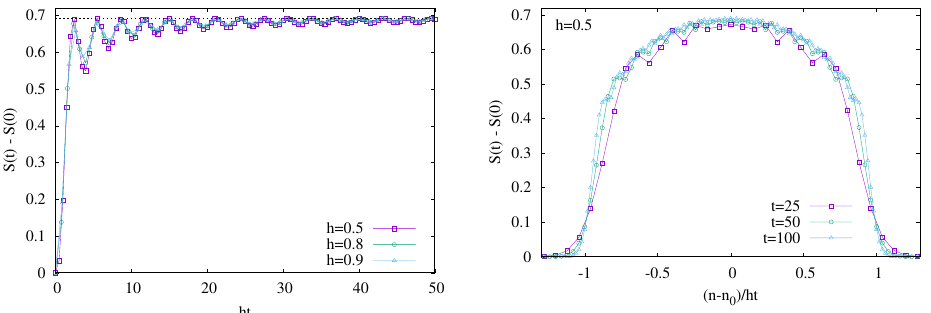
Figure 5: Time evolution of the entanglement entropy for a JW excitation in a chain of size N = 200, with the initial value S ( 0 ) subtracted. Left: half-chain entropy vs. rescaled time for various values of h . The dotted line indicates the value ln2. Right: entropy profiles vs. rescaled distance from chain centre, for fixed h = 0.5 and various